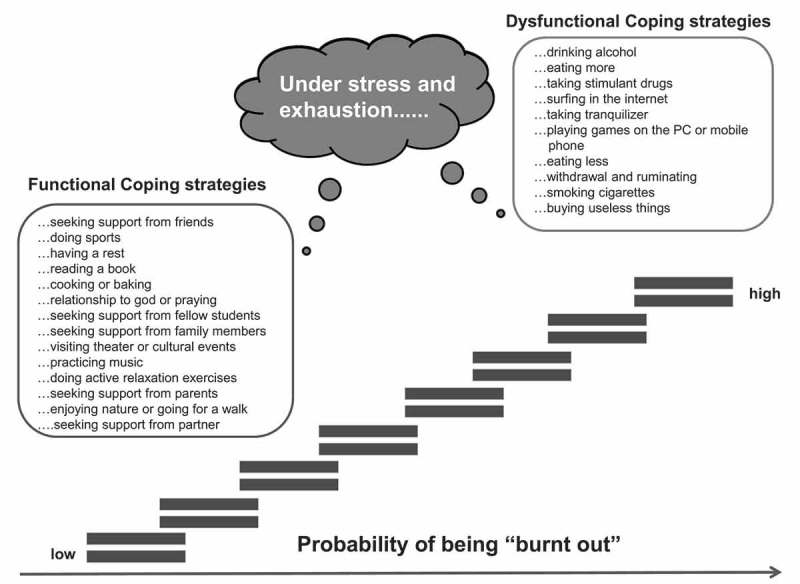
Illustration of hypothesised functional and dysfunctional coping strategies and their association with burnout. The use of functional coping strategies should be associated with a low probability of being burnt out. The use of dysfunctional coping strategies should be associated with a high probability of being burnt out.